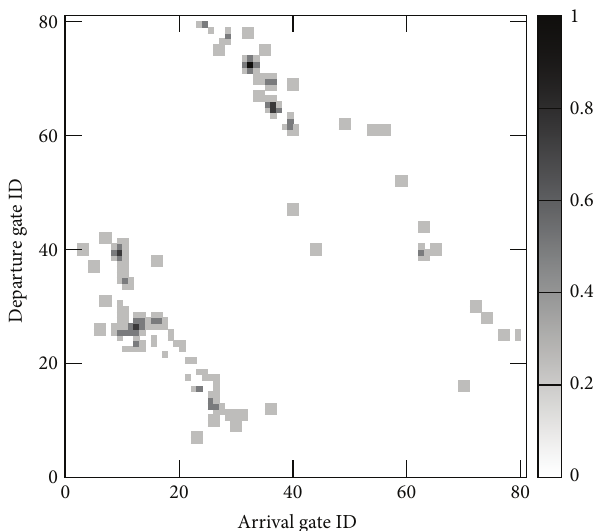
Figure 7: Distribution of gate transition probabilities P 80 ).